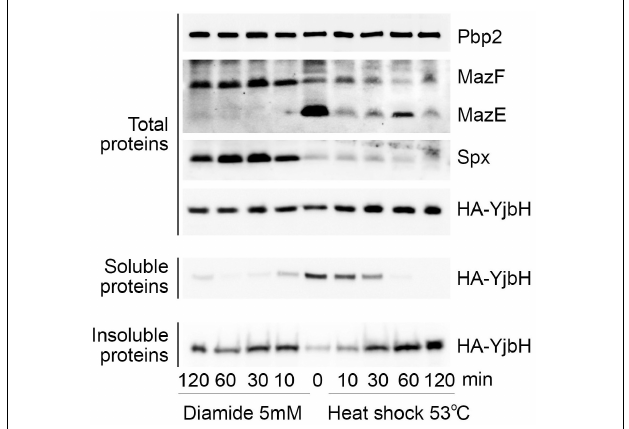
FIGURE 5 | Upon heat shock and oxidative stresses MazE levels correlate with YjbH aggregation and Spx solubility. (cid:49) yjbH cells expressing HA-YjbH were treated with high temperature (53 ◦ C, right), or with 5 mM of diamide (left) for different times, as indicated. Non-treated cells are marked by time 0. Whole cell extracts (Total protein) were adjusted to the same protein concentration and soluble and insoluble proteins were isolated. Samples were separated by gradient (4–12%) SDS-PAGE and analyzed by western blot with anti-HA, anti-Spx, anti-MazE, and anti-MazF antibodies. Pbp2 was used as a control for the equal protein amount in whole cell